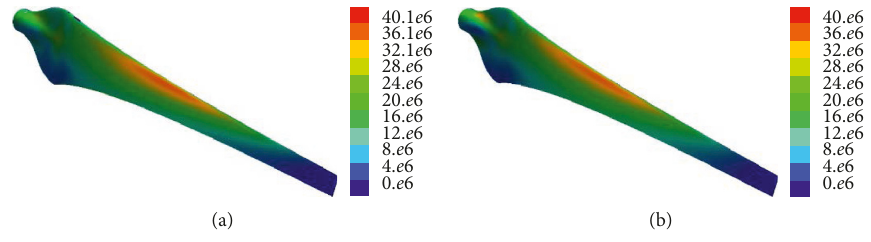
Figure 15: σ , von Mises stress evaluation for E-glass-epoxy and basalt-epoxy at VM (cid:31) (cid:31)(cid:31)(cid:31)(cid:31)(cid:31)(cid:31)(cid:31)(cid:31)(cid:31)(cid:31)(cid:31)(cid:31)(cid:31)(cid:31)(cid:31)(cid:31)(cid:31)(cid:31)